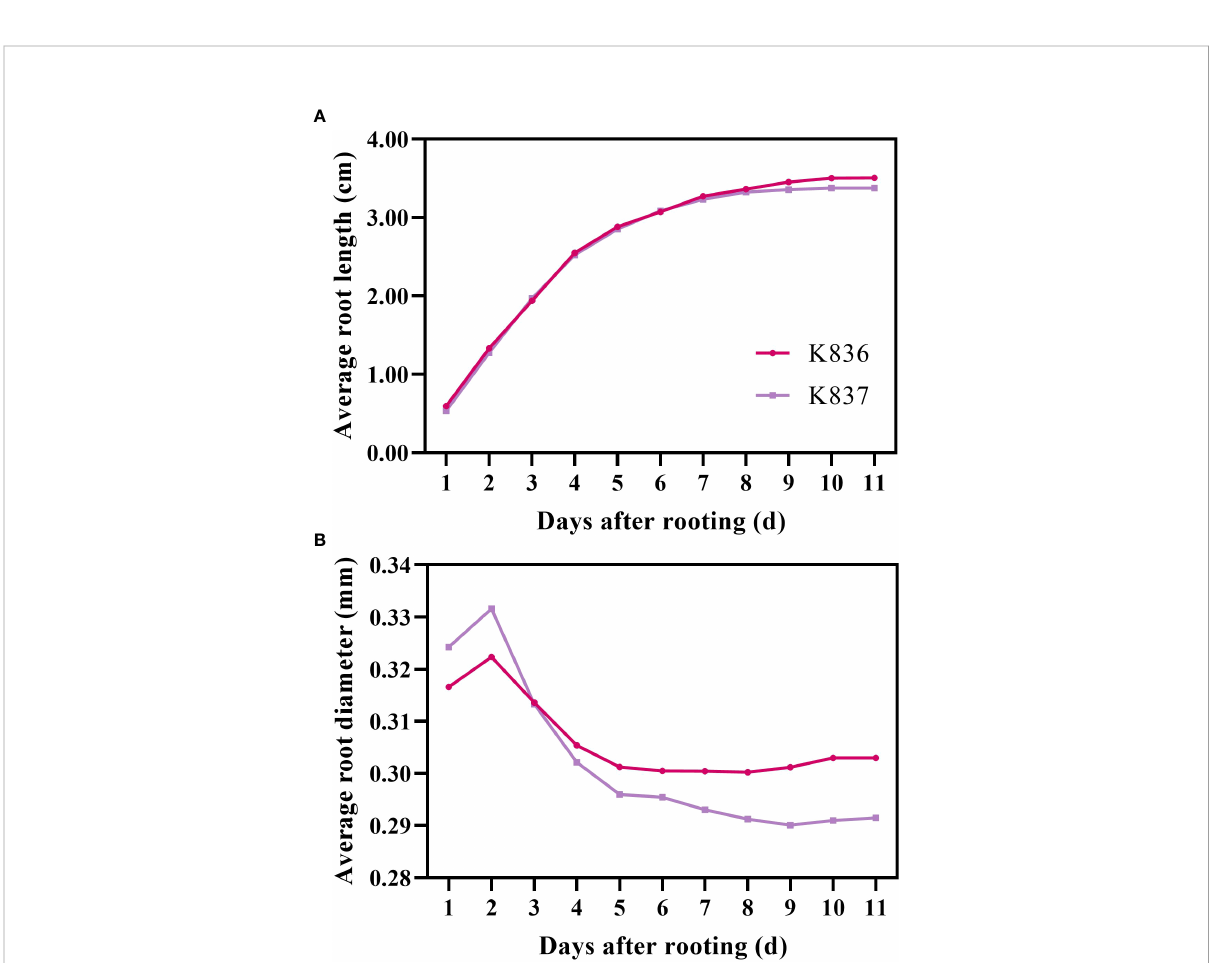
FIGURE 8 Growth rate of average root length and root diameter. (A) Average root length and (B) average root diameter. The primary lateral roots of K836 and K837 were 116 and 92,